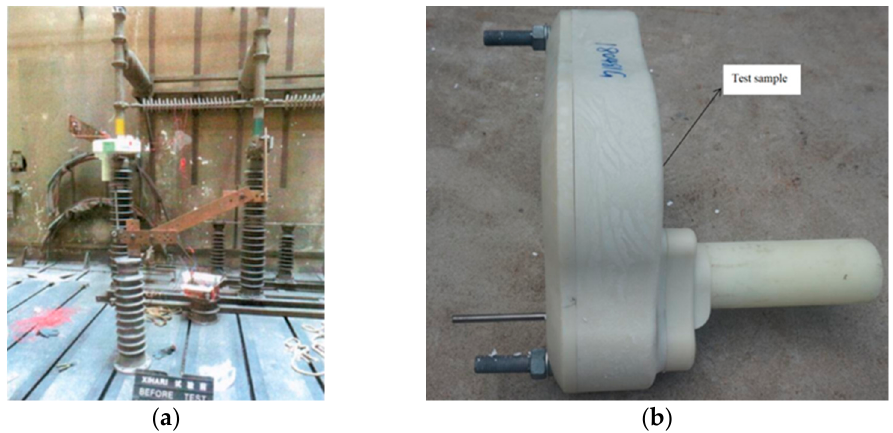
Figure 16. Test installation diagram before the test. ( a ) Pre-test installation scheme. ( b ). A clearer picture of the test sample.